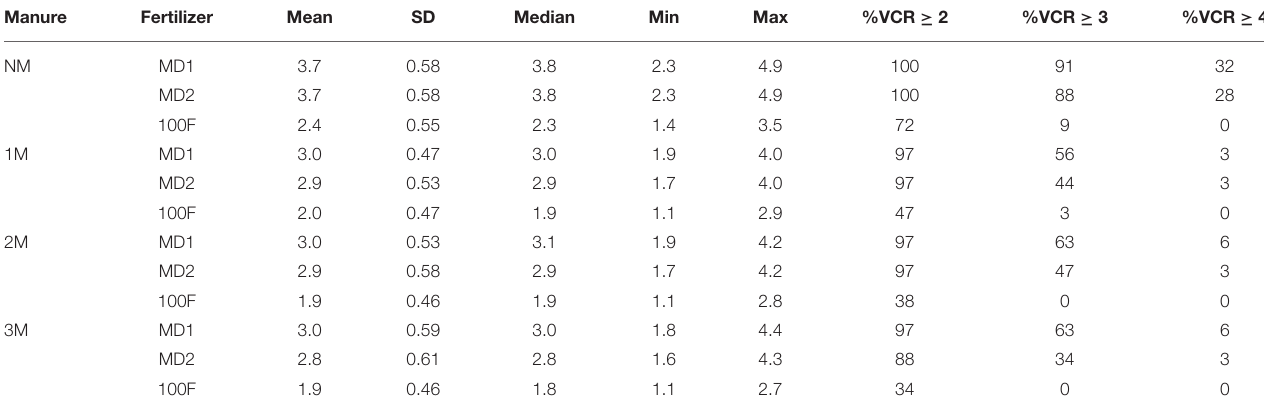
FIGURE 7 | Maize yield variability as simulated by DSSAT over the study period (32 years- − 1984 to 2015) in response to combined application of manure and fertilizer microdosing. NF, no fertilizer; NM, no manure; MD1, microdosing option 1; MD2, microdosing option 2; 100F, 100% of the broadcasted recommended rate. 1M, 2M, and 3M correspond to the application of 1, 2, and 3t ha − 1 of manure. INST, inter-annual standard deviation. TABLE 4 | Summary of simulated impact of seasonal climate variations (32 years − 1984 to 2015) on value cost ratio (VCR) in response to the combined application of manure and fertilizer microdosing. Manure Fertilizer Mean SD Median Min